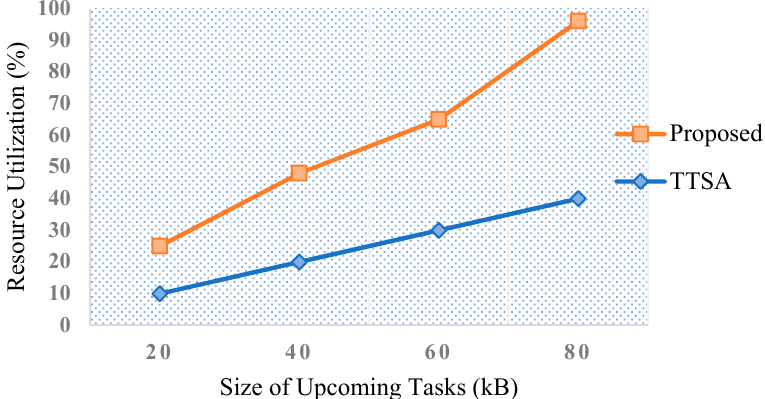
Figure 7. Comparison of resource utilization.